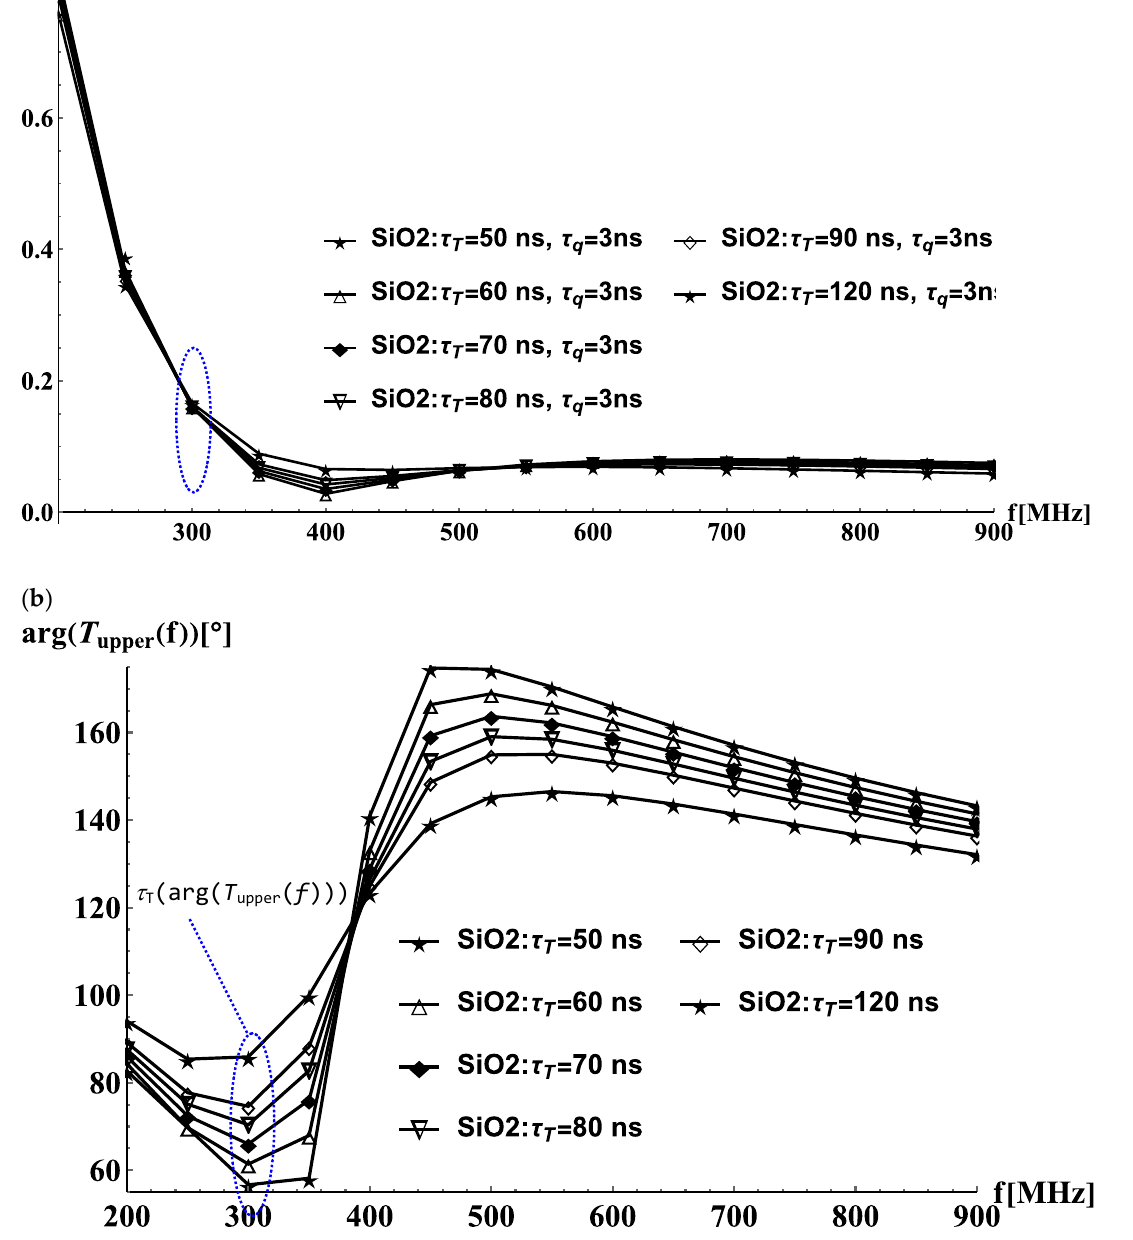
Figure 4. ( a ) The variation in mean temperature across the upper resistor normalised to its temperature at f = 10 MHz. ( b ) The variation in phase-shift of temperature across the upper resistor relative to temperature time-lag of SiO 2 .